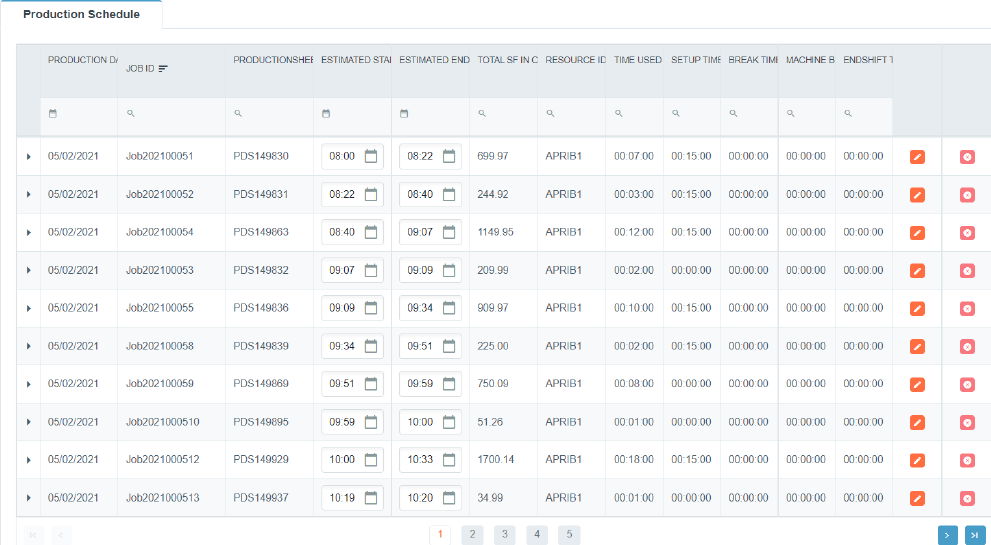
Figure 12. Scheduling